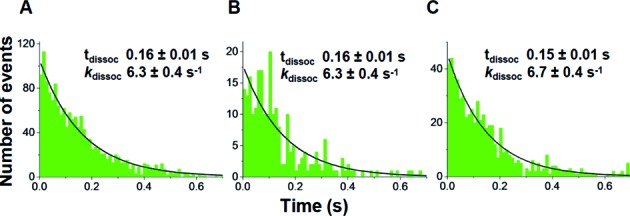
Dissociation times and rate constants for TC interaction with immobilized 70SIC, as determined by smFRET. (A) TCCy3 (5 nM) and 70SICCy5; (B) TCCy3/Cy5 (10 nM) and 70SIC; (C) TCCy3 (10 nM) and 70SICCy5 in the presence of EF-G (4 μM) and 400 μM GTP. Lines are best fits to single exponentials, giving the indicated dissociation (tdissoc) times and corresponding values of kdissoc.